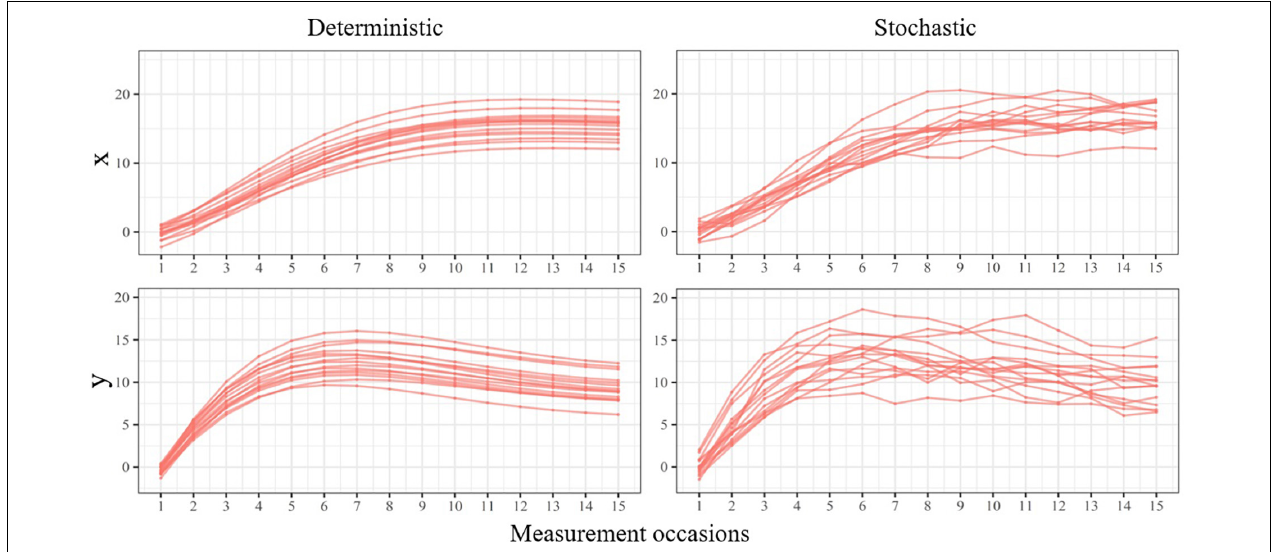
FIGURE 8 | Individual implied trajectories from a deterministic (left) and stochastic (right) BLCS model.